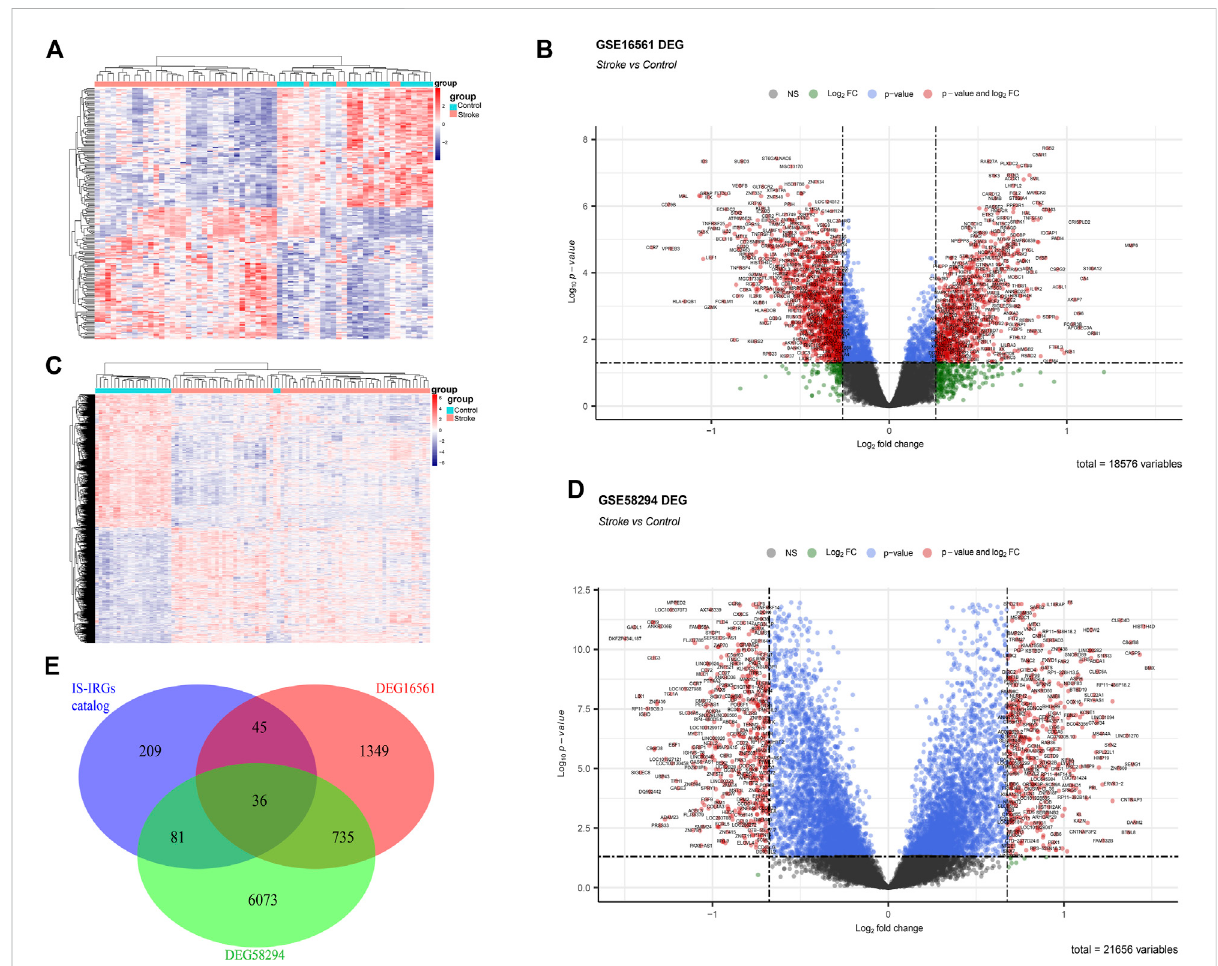
FIGURE 2 Identi fi cation of DEGs and IS immune-related DEGs. (A,C) Heatmap showing the differences in DEGs between ischemic stroke patients and controls in the microarray dataset. (A) represents the GSE16561 data set and (C) represents the GSE58294 data set. (B,D) Volcano plot showing the differences in DEGs between ischemic stroke patients and controls in the microarray dataset. (B) represents GSE16561 data set and (D) represents GSE58294 data set. (E) Venn diagram representation of the intersection of the following three sets: DEGs in the GSE16561 dataset, DEGs in the GSE58294 dataset, and IS-IRGs